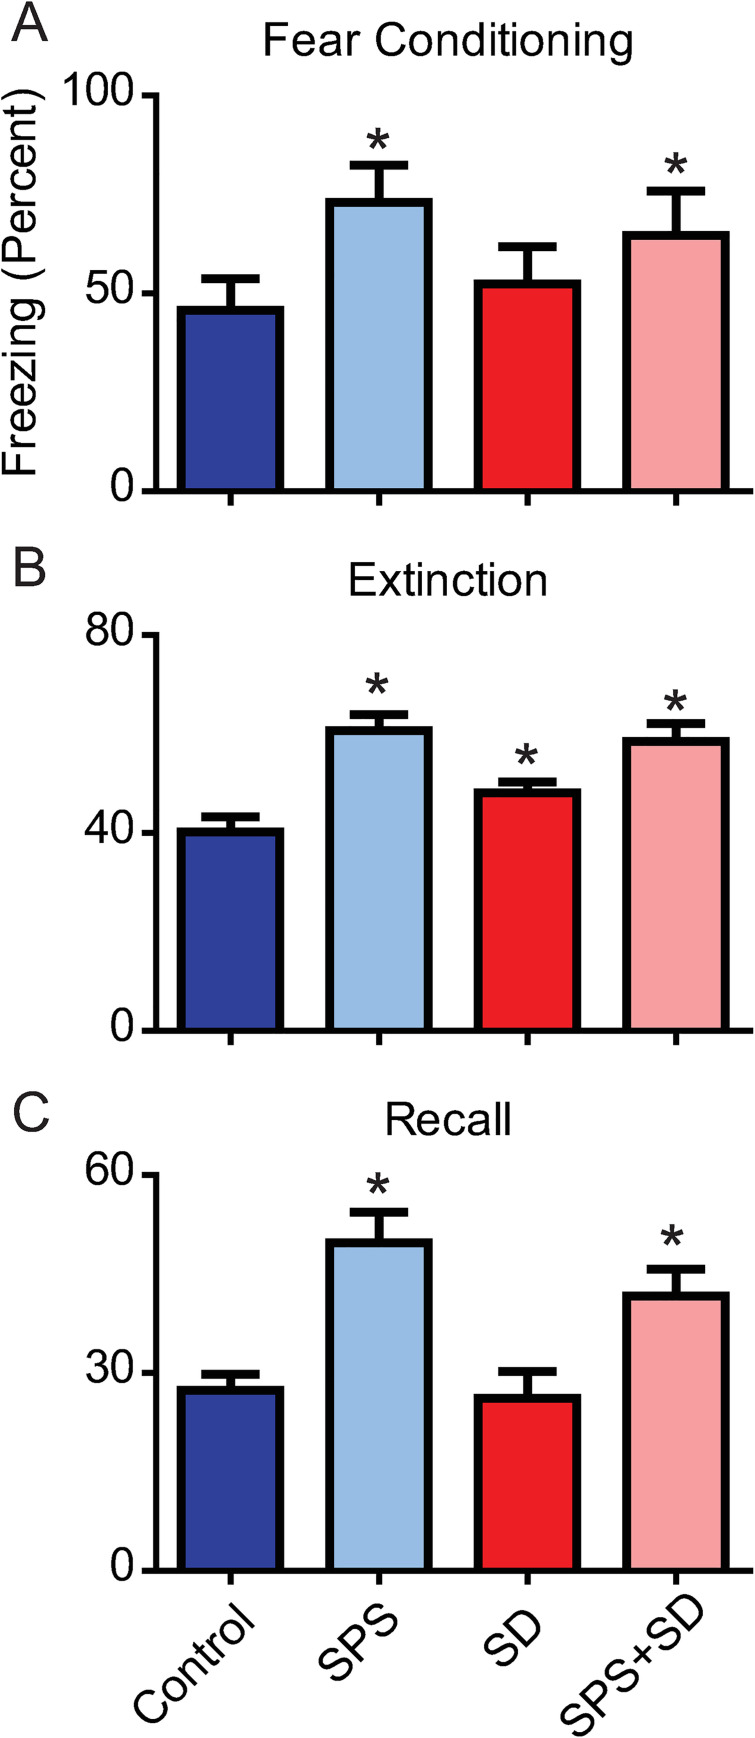
SPS impairs fear-associated memory and sleep deprivation does not further exaggerate fear-associated memory impairments.Each bar represents the average freezing duration (percent) over the fear conditioning (A), extinction (B), and recall (C) phases of the fear-associated memory test. Control animals (dark blue bars) were compared to animals exposed to SPS (light blue bars), SD (dark red bars), or a combination of SPS+SD (light red bars). A one-way ANOVA was used to detect significant effects of treatment, followed by Bonferroni post-hoc analysis., A) A significant main effect of treatment (F(3,19) = 12.95, P = 0.0005) was found during the fear conditioning phase. Post-hoc analysis revealed that SPS (light blue) and SPS+SD (light red) animals froze significantly more than control animals (dark blue). B) A significant main effect of treatment was found during the extinction phase (F(3,119) = 35.42, P < 0.0001). Bonferroni post-hoc analysis revealed that the SPS exposed, SD, and SPS+SD groups froze significantly more than control animals. C) A significant main effect of treatment was found during the recall phase (F(3,39) = 26.28, P < 0.0001). Bonferroni post-hoc analysis showed that SPS treated (light blue) and SPS+SD (light red) treated animals froze significantly more than control animals (dark blue) * = P < 0.05.